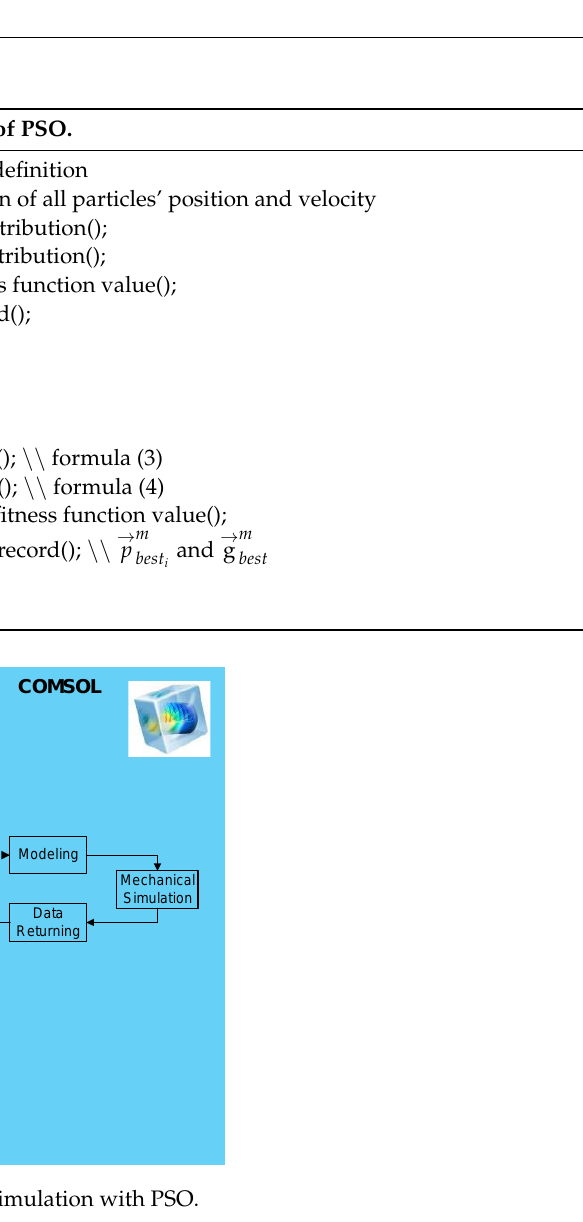
Figure 3. The flow chart of co-simulation with PSO. Initialization: The optimized parameters include the width, the slope of the contact plane, and the fillet radium of CMI. The ranges of the optimized parameters are defined first, and the ranges of velocities are defined to be ten percent of the corresponding